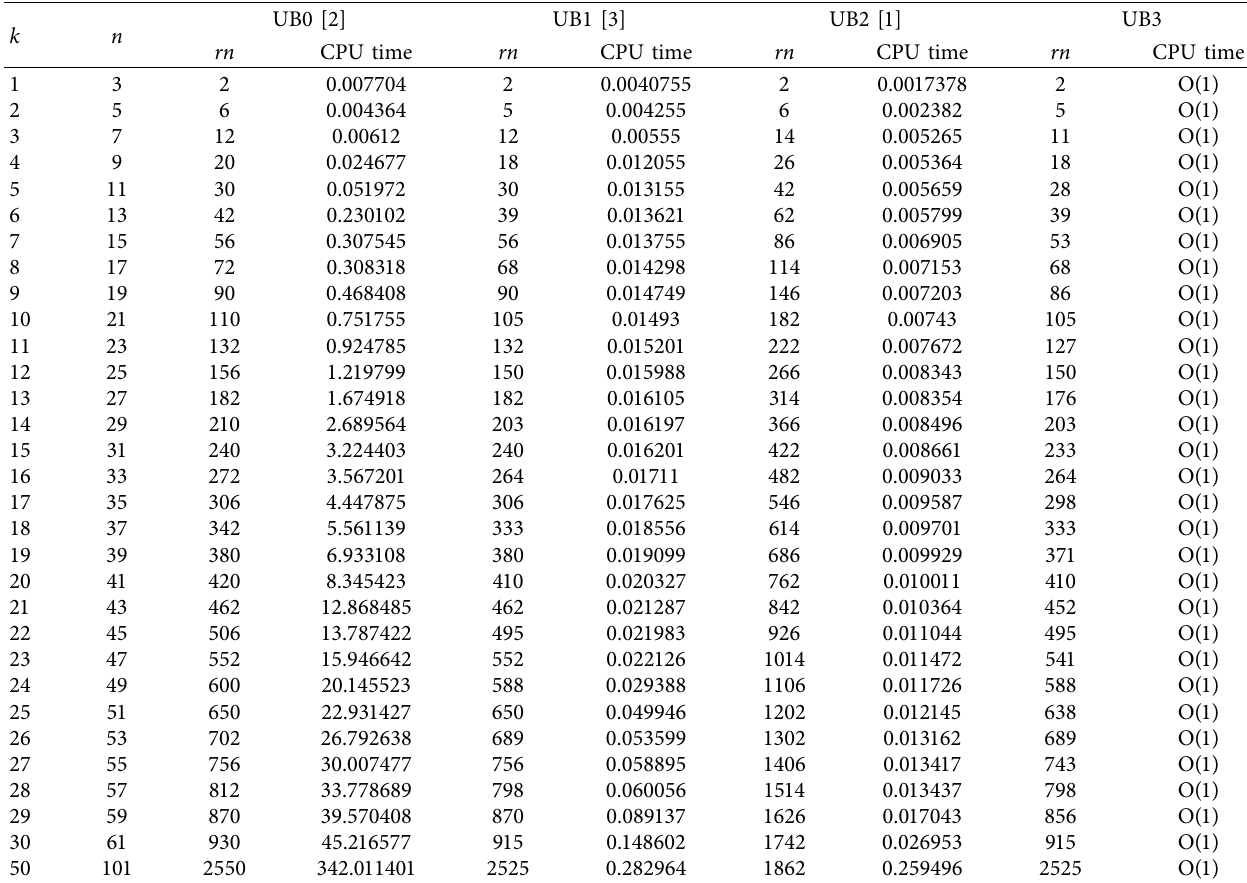
Table 1: Comparison between standard radio number and the upper bound of radio number for the triangular snake